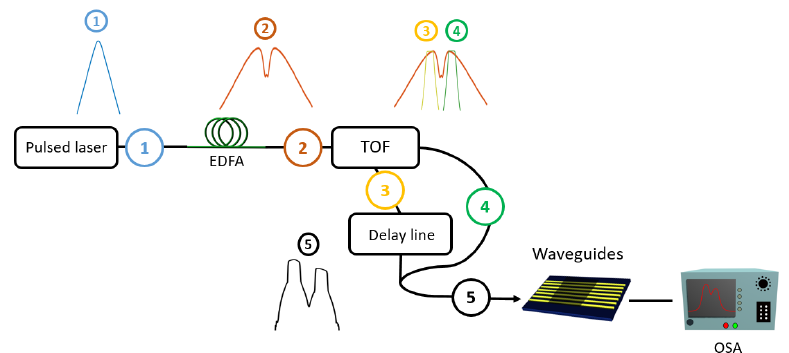
Figure 2. Experimental setup used to perform pulsed FWM in the graphene-covered waveguides. (1) The pulsed laser delivers Fourier-limited pulses ( τ FWHM = 2ps). (2) The pulses are amplified and spectrally broadened upon propagating in the erbium-doped fiber amplifier (EDFA). A tunable optical filter (TOF), WaveShaper 4000s ® is used to filter and split the signal into two channels: (3) the pump, λ p = 1545nm with a width of ∆ λ = 2nm and (4) the probe, λ s = 1549nm with a width of ∆ λ = 2nm. A delay line is added on the pump channel to synchronize the two signals reunited in (5) just before coupling to the waveguides. An optical spectrum analyser (OSA) then measures the spectrum after propagation in the graphene-covered